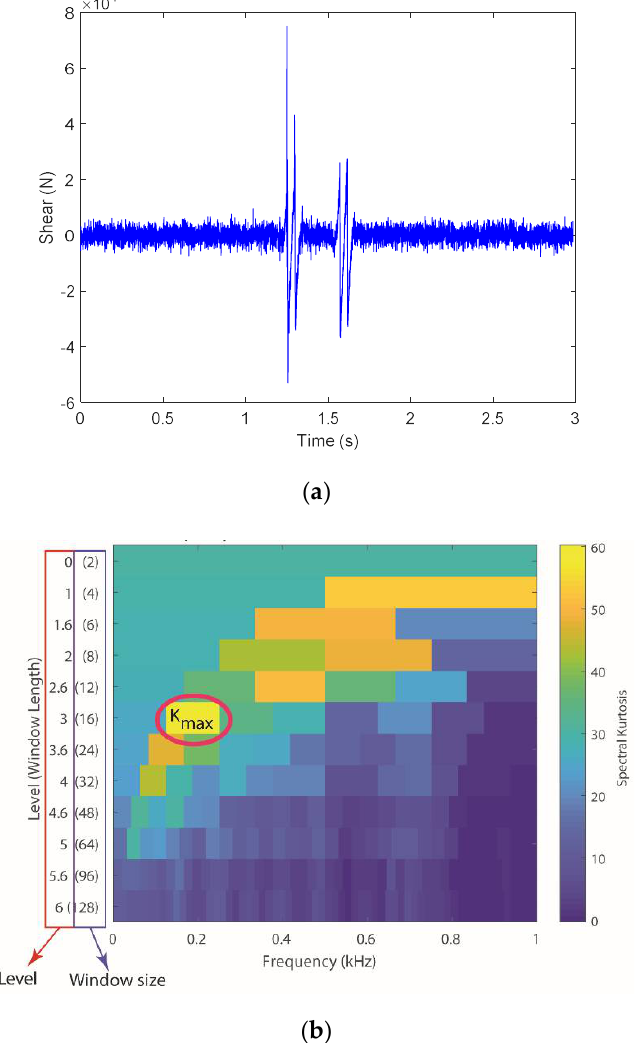
Figure 8. ( a ): Main signal evaluated from position 9 regarding layout scheme 1. ( b ): Spectral kurtosis for a signal corresponding to the Alfa Pendular train, K max = 60.25 Hz, optimal window length = 16, center frequency = 0.1875 kHz, bandwidth frequency = 0.125 kHz.